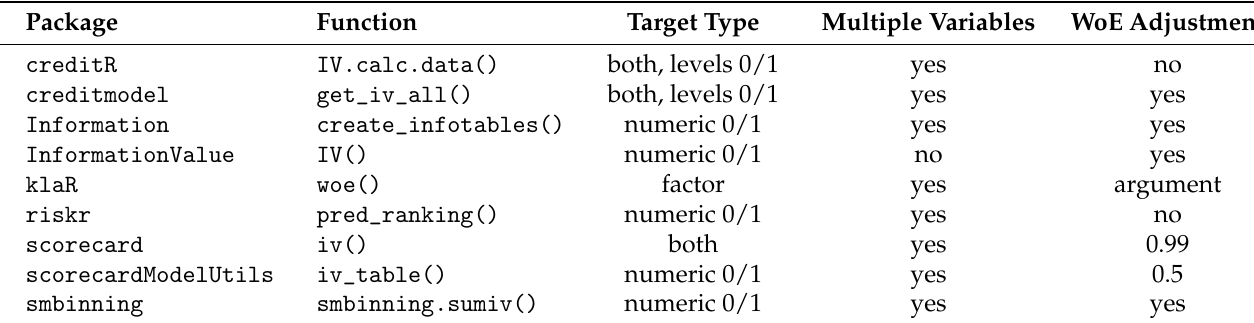
Table 4. Packages and functions for computation of